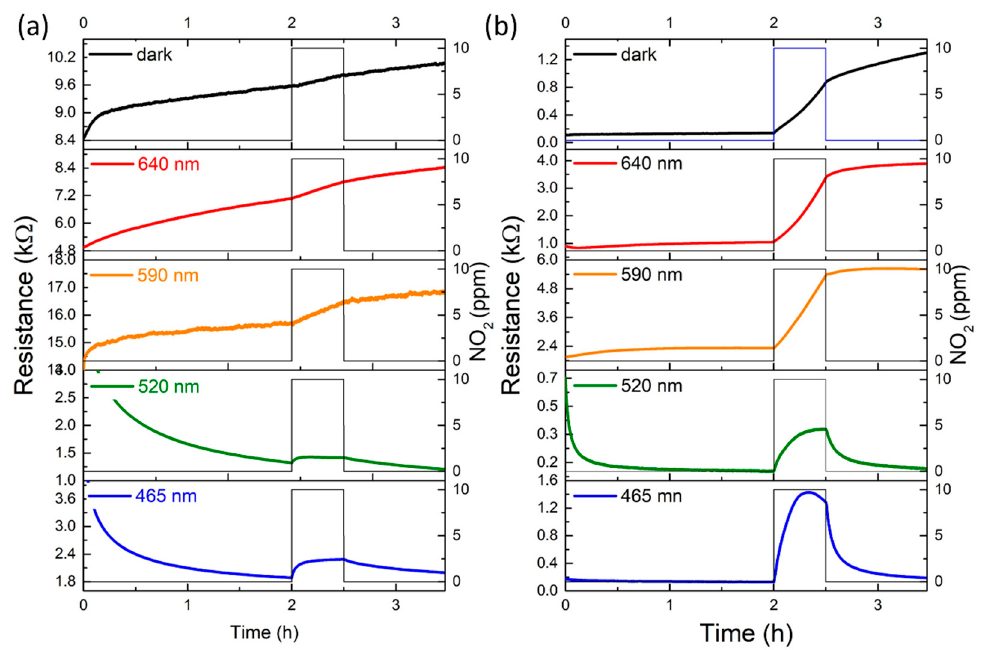
Figure 8. Sensing responses of ( a ) the bare ZnO NRs and ( b ) the ZnO NRs/Au NPs. The sensitivity for green and blue LED of the bare ZnO NRs is 7.2% and 19.3%, respectively, while the ZnO NRs/Au NPs is 191% and 891%, respectively, for the green and blue LED.